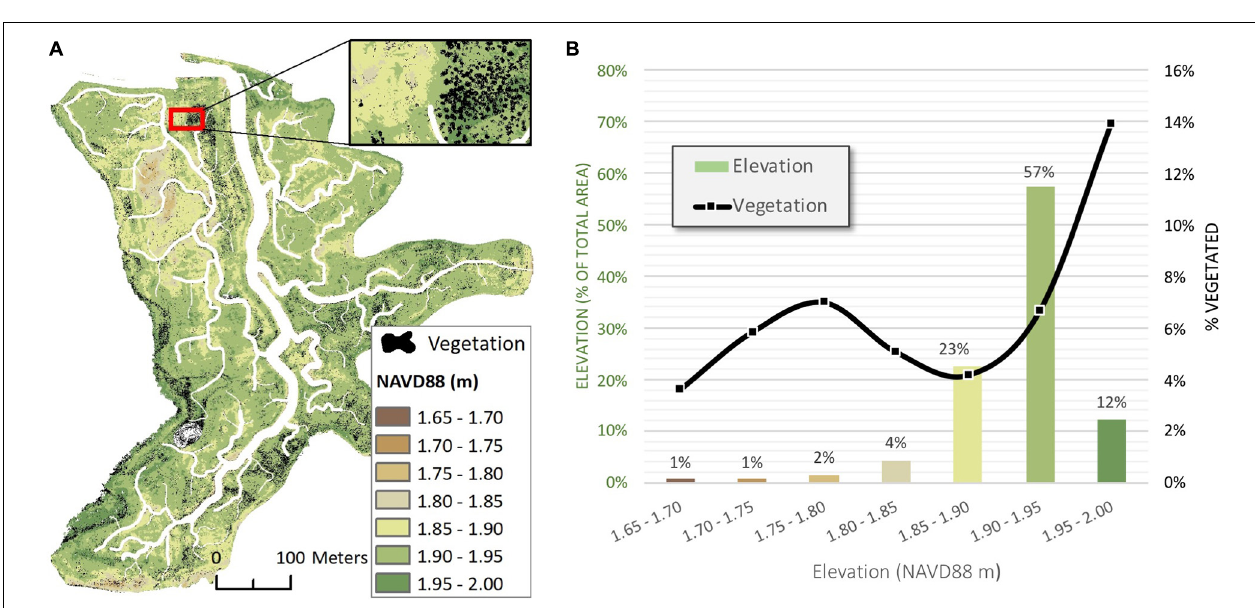
FIGURE 5 | Maps collected during construction (June 2018) and at the end of construction (August 2018) showing a narrow peninsula that was constructed following old creek network designs, and then changed to reflect updated designs. We primarily used orthomosaics to monitor construction, but present DEMs here to make the change more easily visible. Note lower DEM resolution in the June 2018 imagery due to different processing technique with no GCPs.